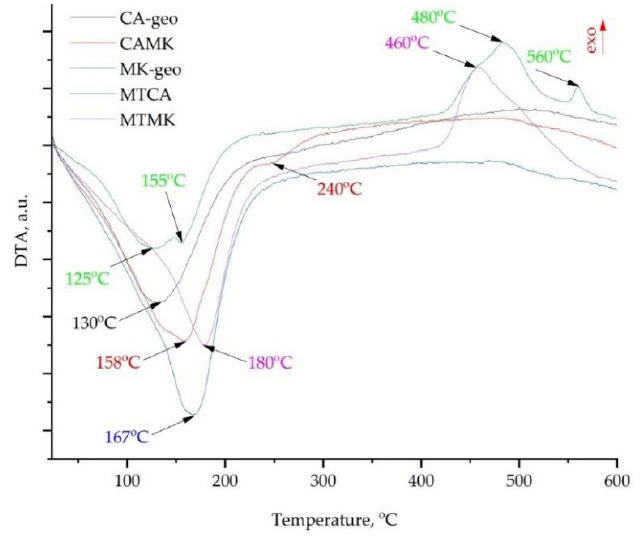
Figure 6. DTA plots of the studied geopolymers.